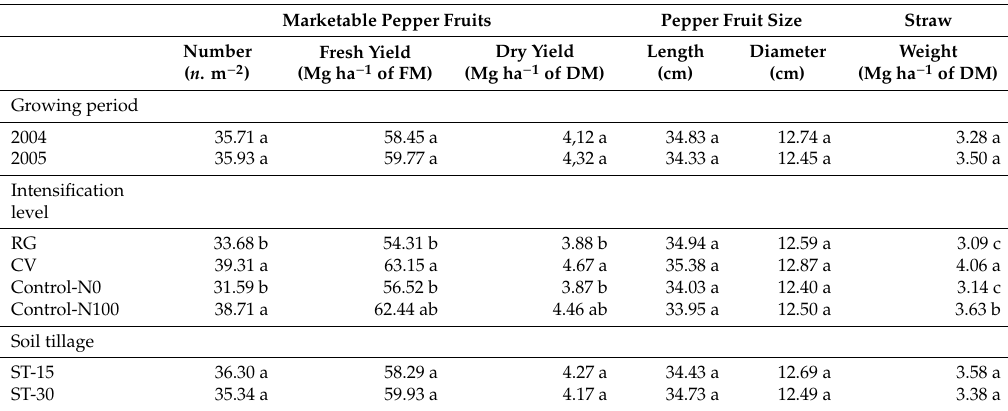
Table 4. The main e ff ect of growing periods, intensification level, and soil tillage on marketable fruit yield and yield characteristics of pepper crop. Values belonging to the same variable followed by the same letter are not statistically di ff erent, according to LSD (0.05).